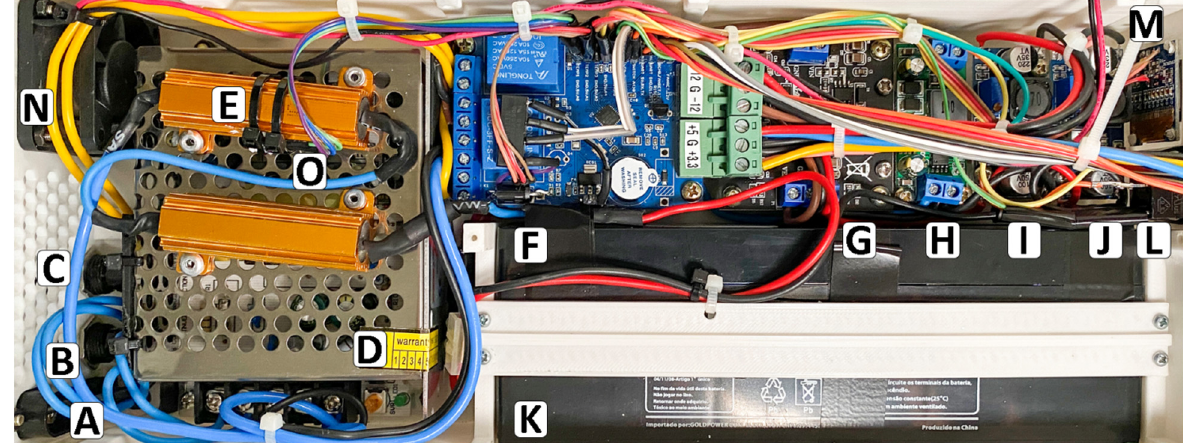
Figure 7. Electronics parts inside the power supply: A—Input connector type 8, B—ON/OFF switch, C—Fuse holder, D—AC/DC converter, E—50 W resistor, F—MCU board, G—Bipolar symmetric regulator, H—BMC, I—5 V regulator, K—9 V battery, J—3.3 V regulator, L—Logical switch, M—OLED display, N—Cooler, O—Temperature sensor.